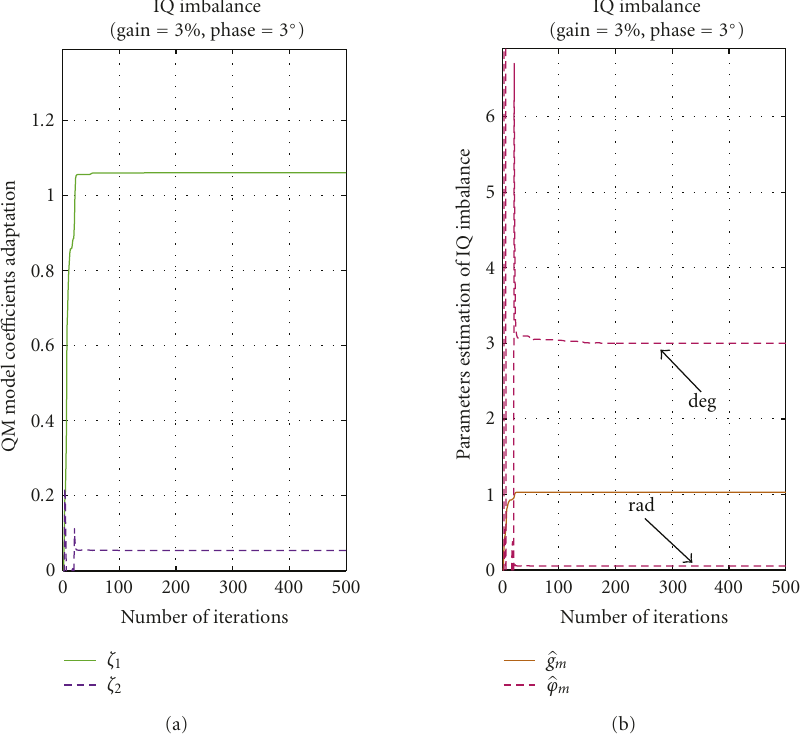
Figure 10: Convergence behavior of (a) QM model coe ffi cients adaptation (b) the corresponding parameters estimation of IQ imbalance.